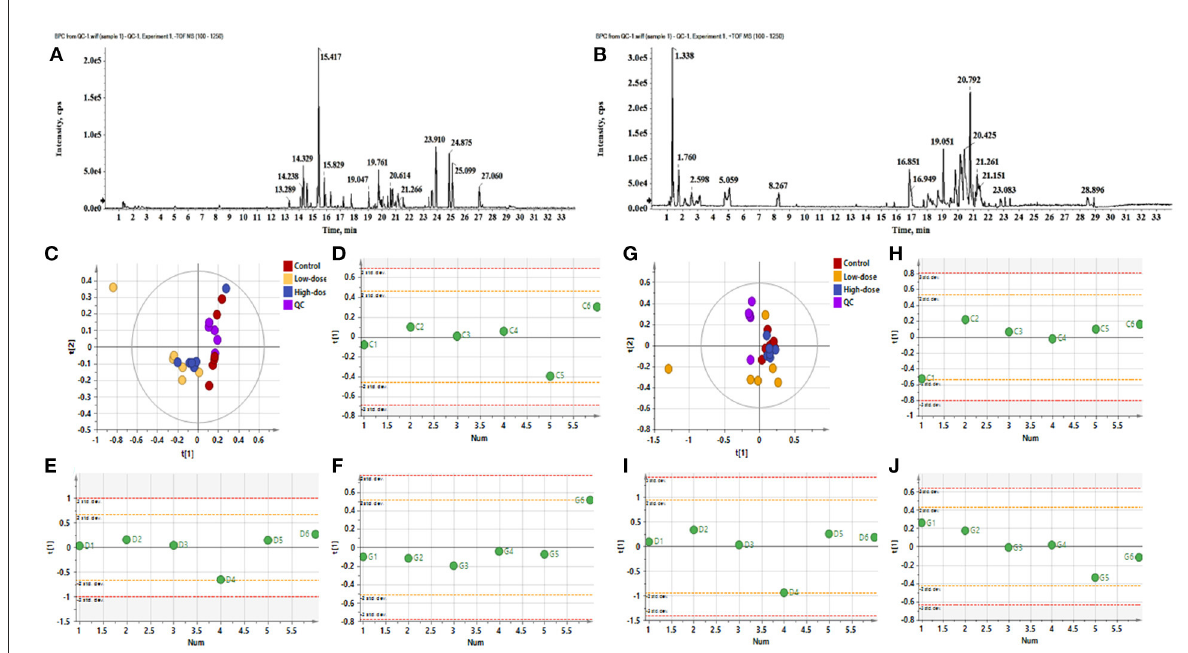
FIGURE1 The BPC diagram of QC samples in positive and negative ion mode. (A) Negative ion mode, (B) Positive ion mode. (C–F) PCA analysis of negative ions. (C) PCA analysis of all samples (R 2 X 0.756, Q 2 0.396), (D) PCA-class analysis of Control group, (E) PCA-class analysis of Low-dose group, (F) PCA-class analysis of High-dose group. (G–J) PCA analysis of positive ions. (G) PCA analysis of all samples (R 2 X 0.566, Q 2 0.0992), (H) PCA-class analysis of Control group, (I) PCA-class analysis of Low-dose group, (J) PCA-class analysis of High-dose